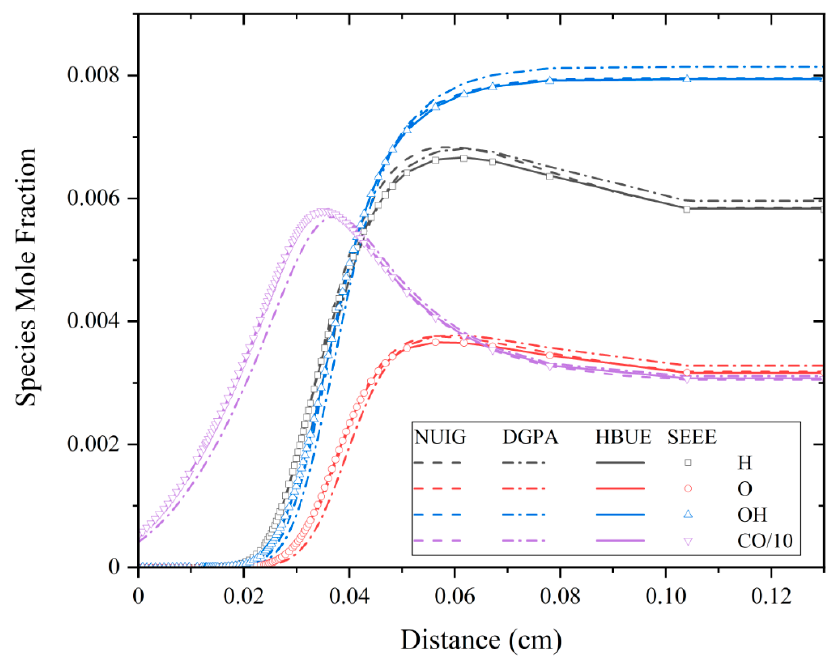
Figure 13. Comparison of the mole fraction for the key oxidation species between NUIG, DGPA, HBUE, and SEEE for burner-stabilized flame at an equivalence ratio of 1.0 and an unburned gas temperature of 298 K.